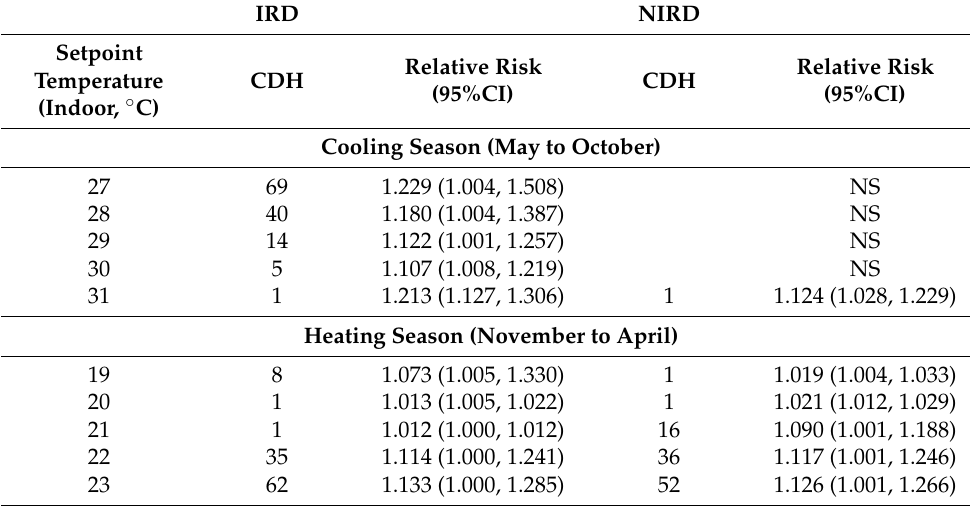
Table 3. Cooling and heating cumulative degree hours for infectious and non-infectious respiratory disease-related emergency department visits for older adults from 2006 to